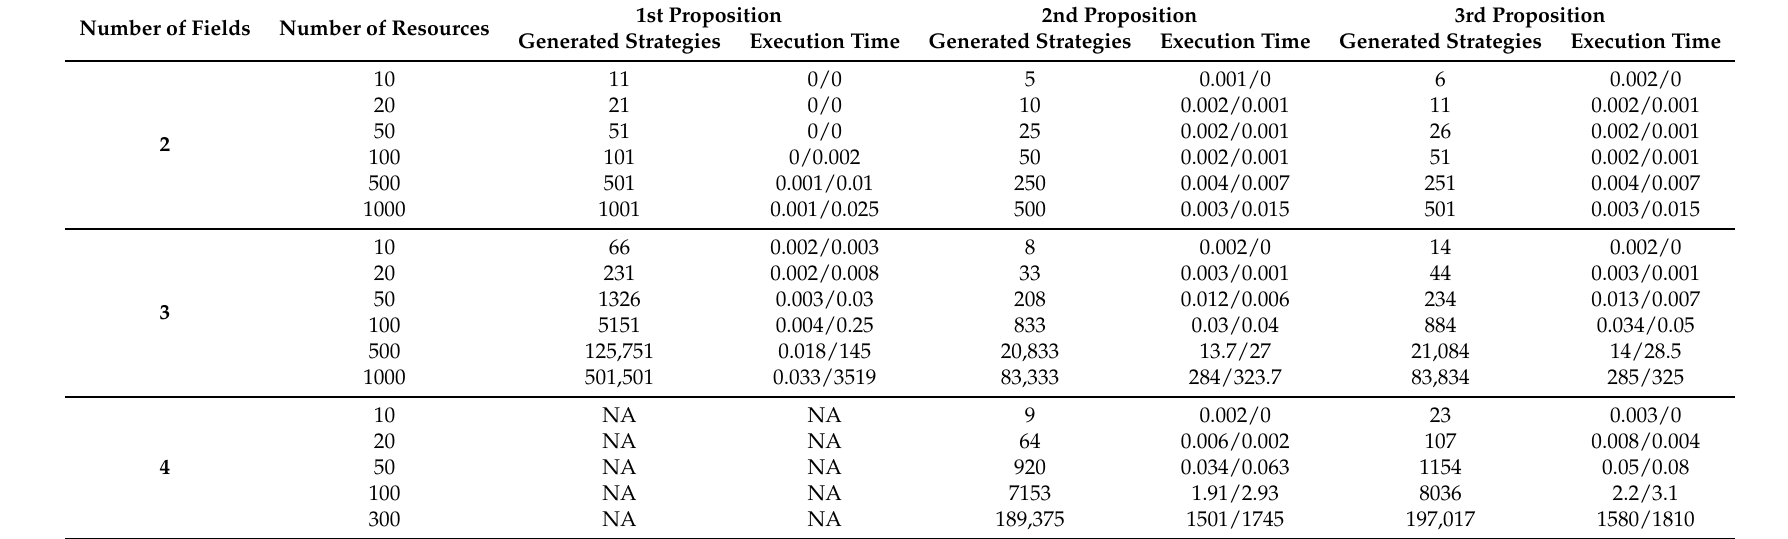
Table 2. Results of some executions of the algorithms of the proposed